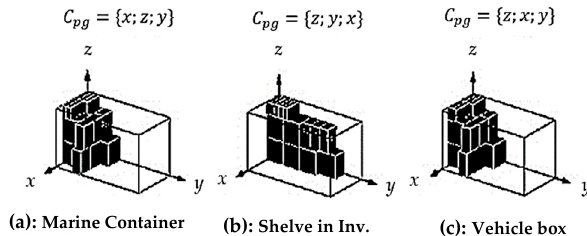
Figure 6. Load of potential orthogonal container (drawer).